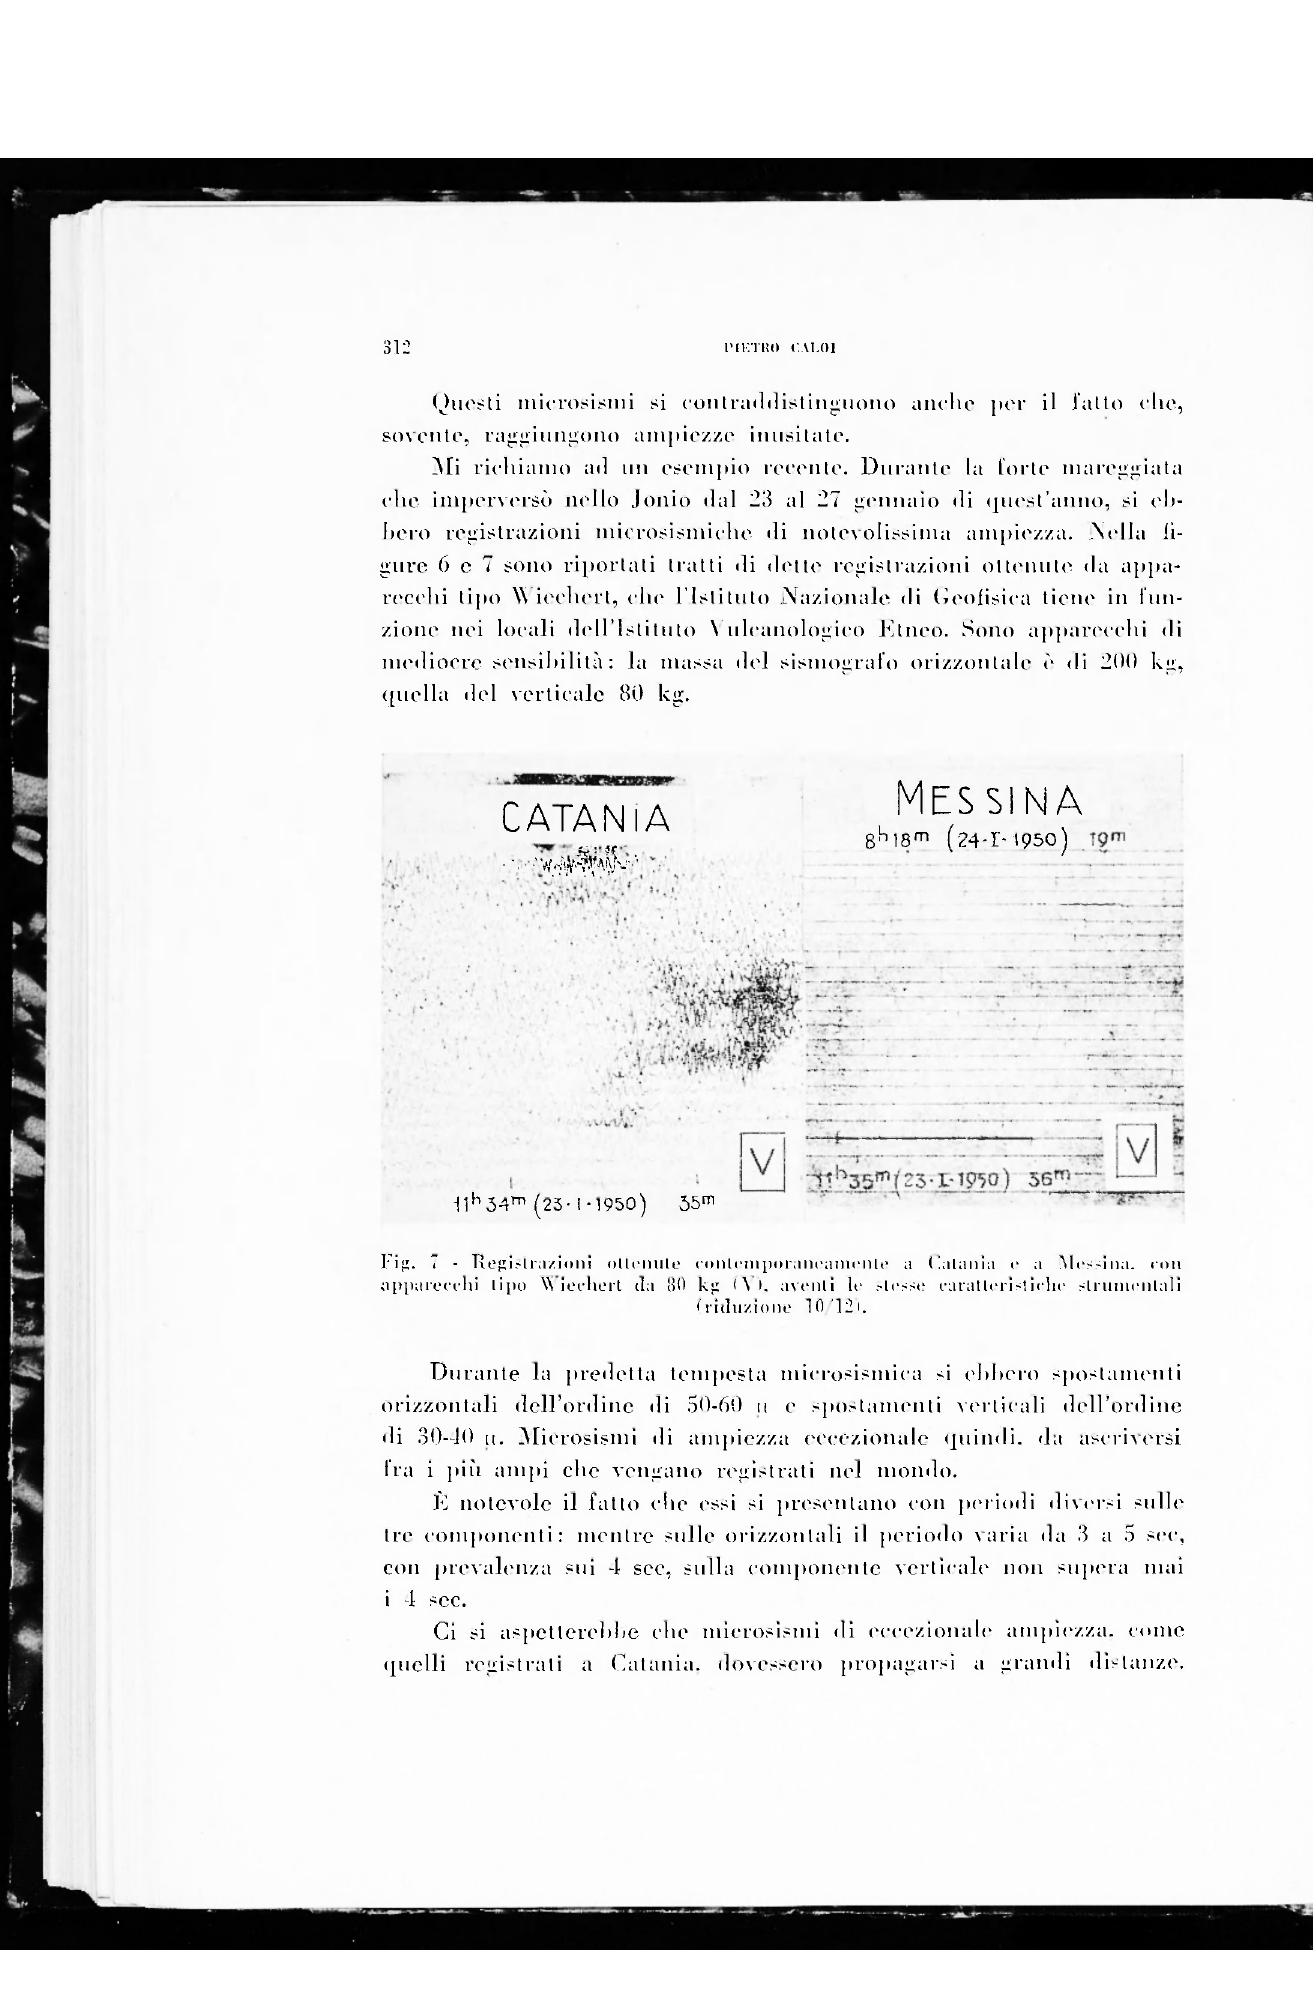
Fig. 7 - Registrazioni ottenute contemporaneamente a Catania e a Messina, con apparecchi tipo Wiechert da 80 kg (A I, aventi le stesse caratteristiche strumentali (riduzione 10